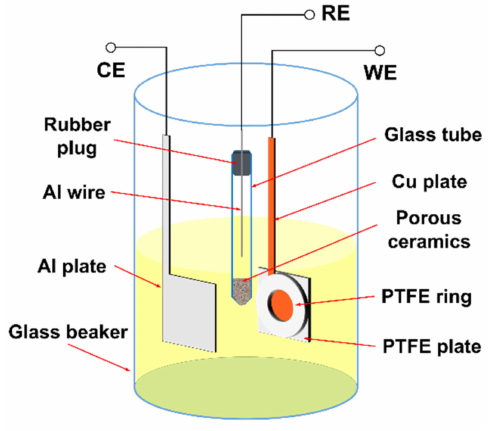
Figure 1. Schematic of the three-electrode cell used for the electrochemical experiments under the restricted diffusion